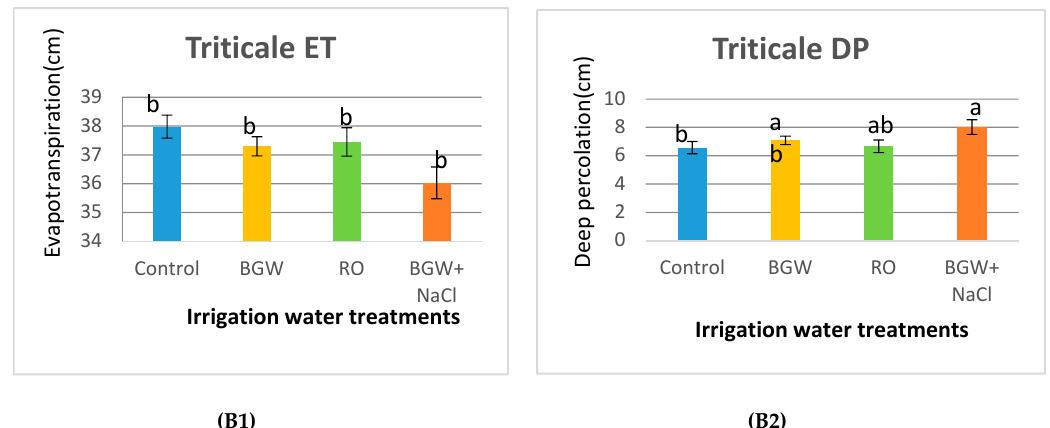
Figure 2. ( A1, A2 ) Total evapotranspiration (ET) and total deep percolation (DP) in alfalfa. ( B1, B2 ) Total evapotranspiration and total deep percolation in triticale. Means within species sharing the same letter are not significant at α ≤ 0.05. Each observation is the mean ± SEs of four replications. The electrical conductivities (ECs) of the saline treatments were control (0.7 dSm − 1 ), BGW (4 dSm − 1 ), RO (8 dSm − 1 ), and BGW + NaCl (8 dSm − 1 ).